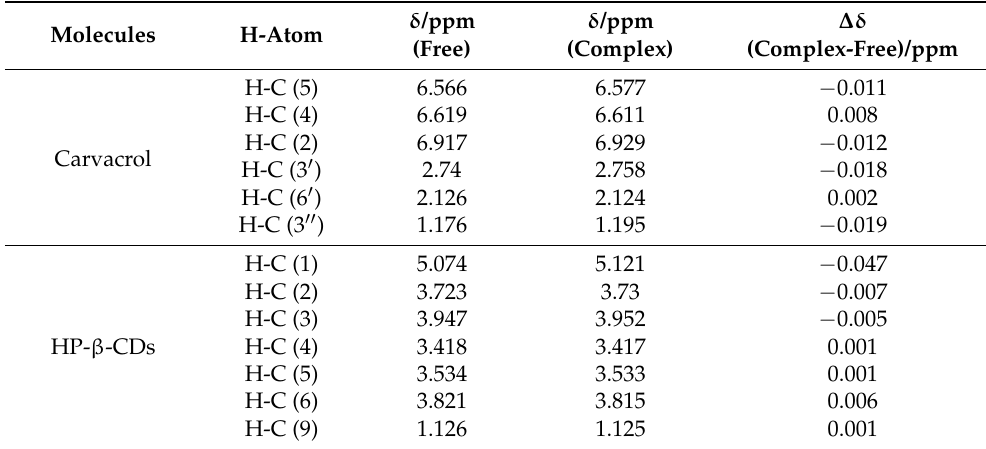
Table 3. Chemical displacement of carvacrol and HP- β -CD, both in free form and when complexed in